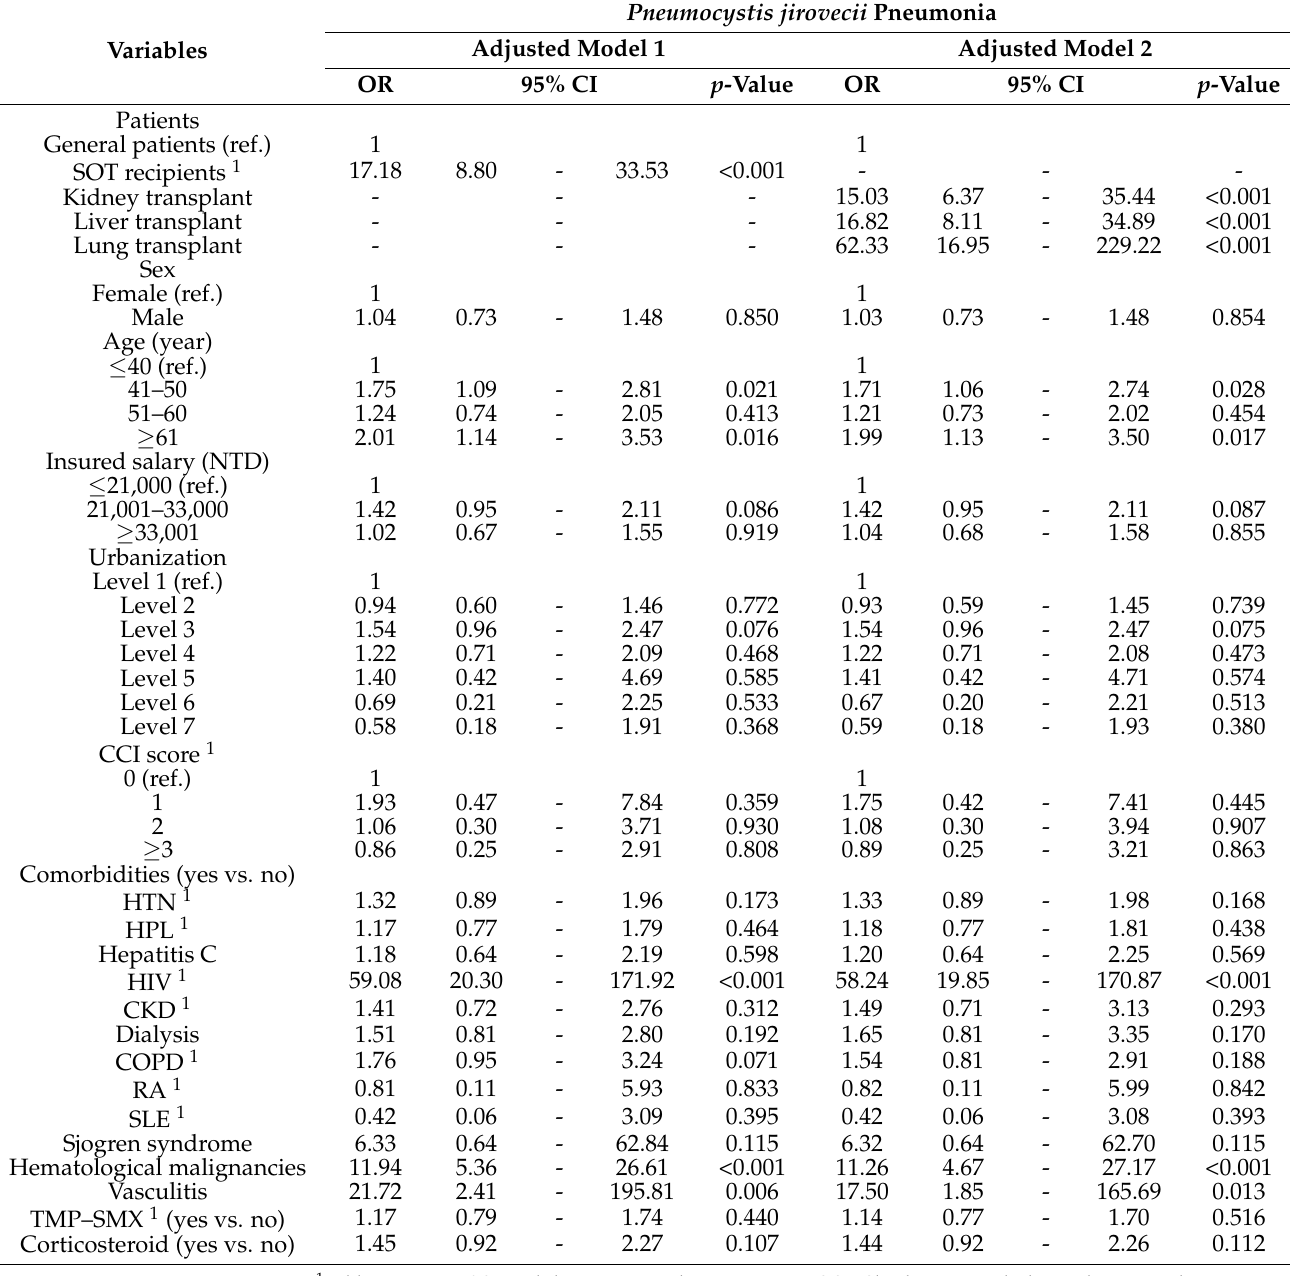
Table 2. Three-year follow-up of incidence Pneumocystis jirovecii pneumonia in solid organ trans- plant